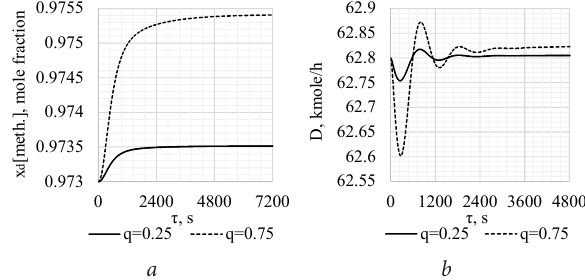
Fig. 2. Transient responses when changing the ratio of the feed flows rates by the channels: a – “feed redistribution degree – methanol concentration in the distillate”; b – “feed redistribution degree – flow rate of